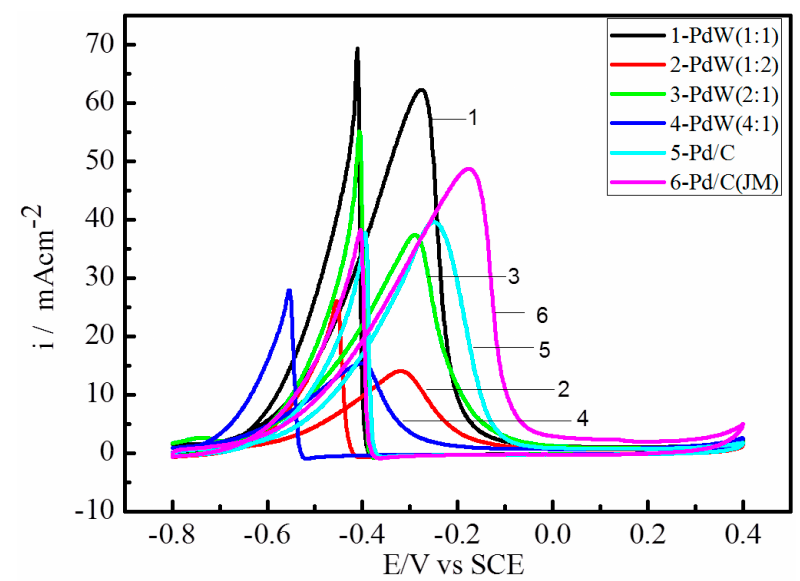
Figure 4. Voltammetric curves of Pd-based catalysts in 1 M KOH +1 M C 2 H 5 OH solution at 50 mV·s − 1 .